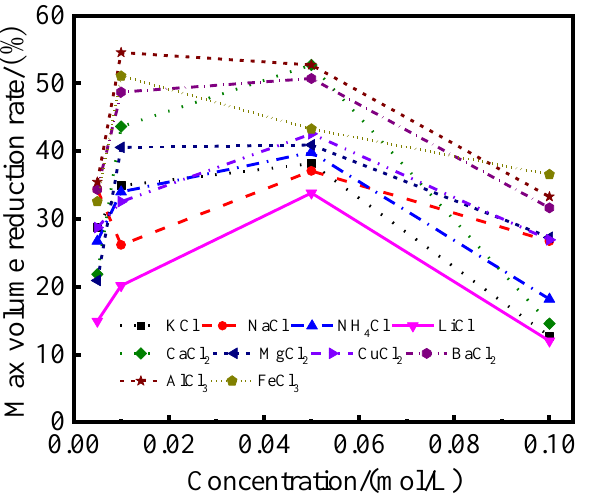
Figure 2. Effect of modifier solution concentration on maximum volume reduction rate of samples based on different modifiers.